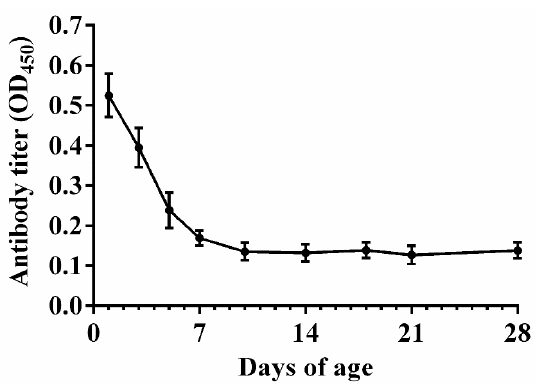
Figure 2. Natural anti-APEC maternal antibody levels in the serum collected from commercial broiler chicks during the 1–28 days of age (n = 5). Data are presented as mean ± SE.